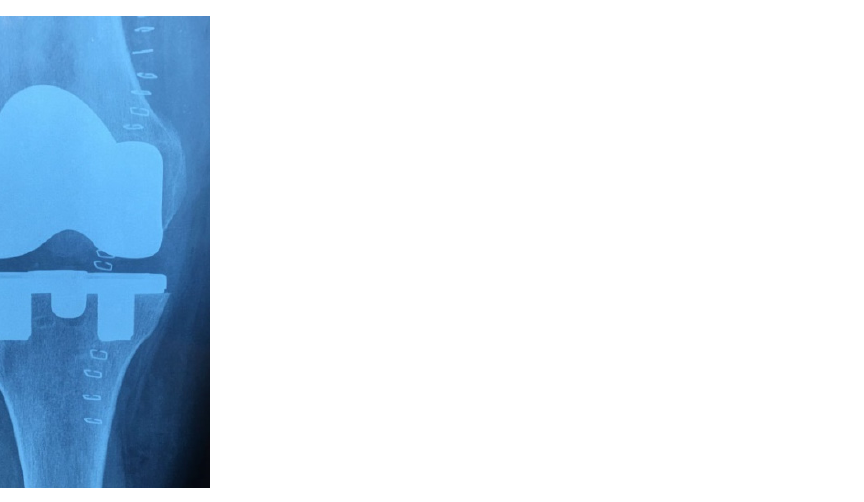
Figure 3. Radiographic image of a TKA using a three-peg modular TMT tibial component.